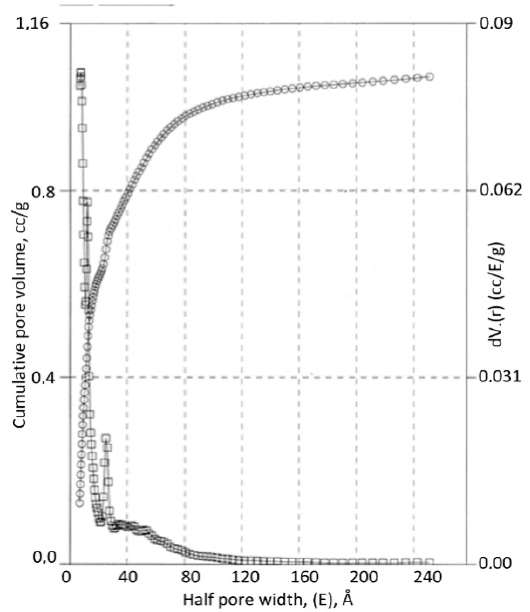
Figure 4. The function of pore volume distribution on the effective radius of ZL-302 activated carbon (Ssp. = 1618 m 2 /g; Vs = 1.13 cm 3 /g), ○ —V, □ —dV.